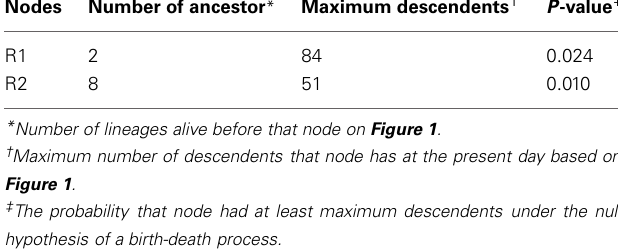
Figure 1 . ‡ The probability that node had at least maximum descendents under the null hypothesis of a birth-death